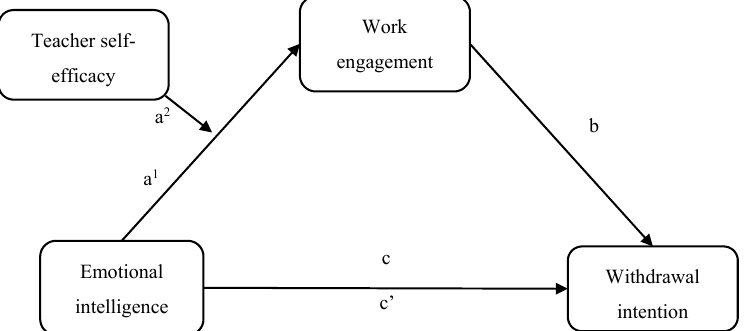
Figure 1. Representation of the proposed model. Note: a 1 = direct effect of emotional intelligence; a 2 = direct effect of teacher self-efficacy; b = total effect of work engagement; c = total effect of emotional intelligence; c’ = direct effect of emotional intelligence.